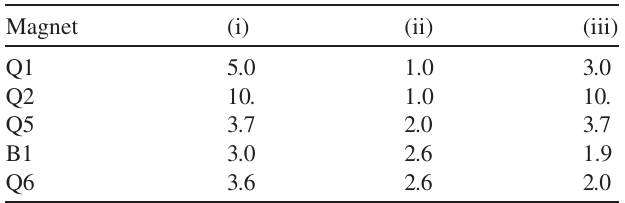
TABLE VI. Peak power density ( mW = g ) in most vulnerable magnets in three considered cases.